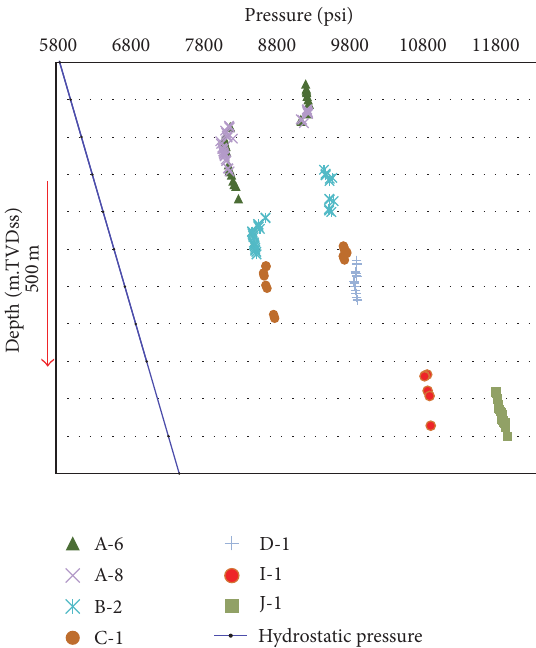
Figure 4: The pressure versus depth plot of the Lower Fahliyan reservoir. The red line is lithostatic pressure gradient (1psi/ft); the blue line is hydrostatic pressure gradient (0.46 psi/ft). The measured pressure data from seven wells plotted between these two lines indicating overpressuring of the Fahliyan reservoir in all seven different wells. The area inside the square denotes a zoomed-in version, Figure 5.